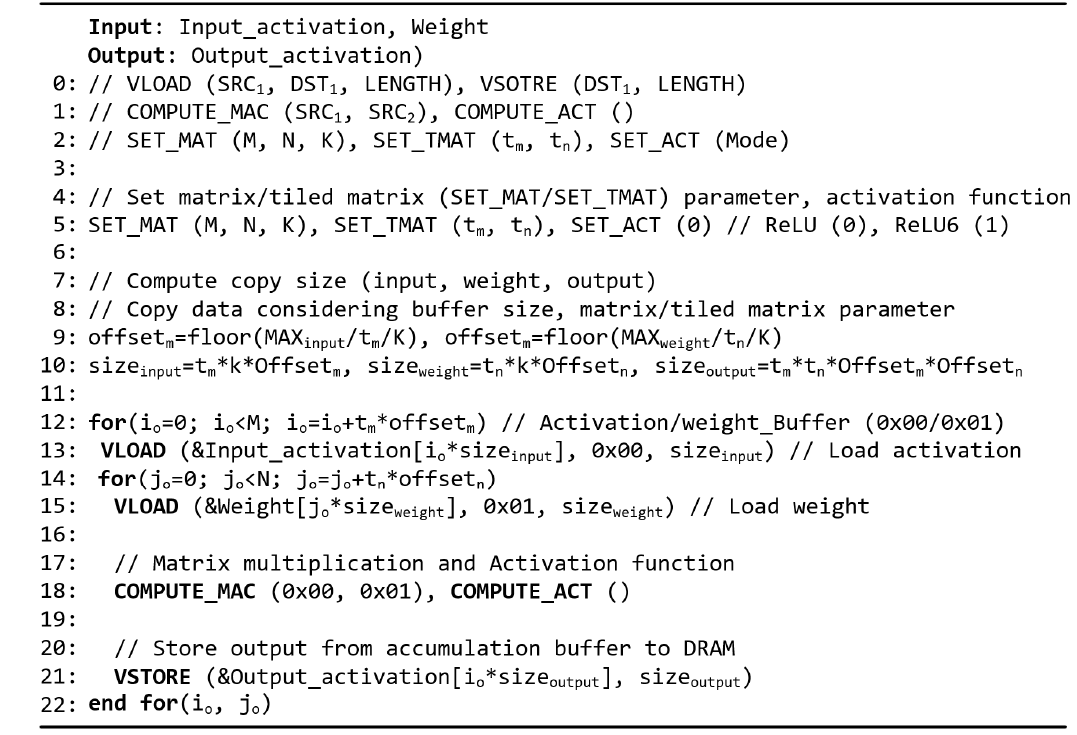
Figure 14. Pseudocode of the convolution layer with CONNA instructions.